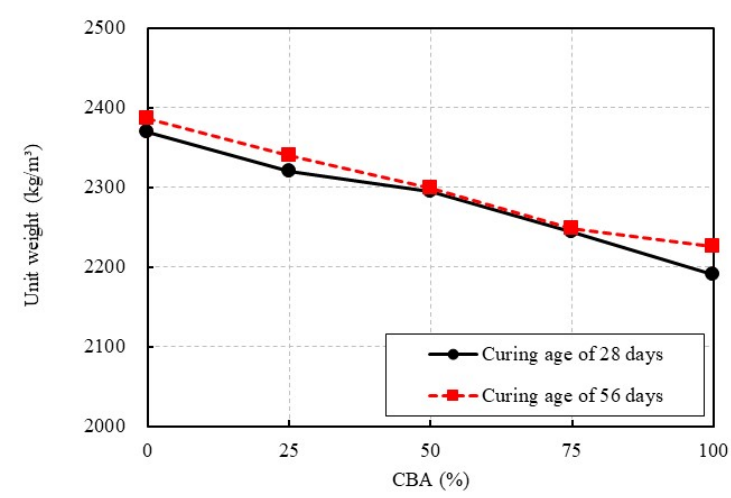
Figure 6. Unit weight test results.